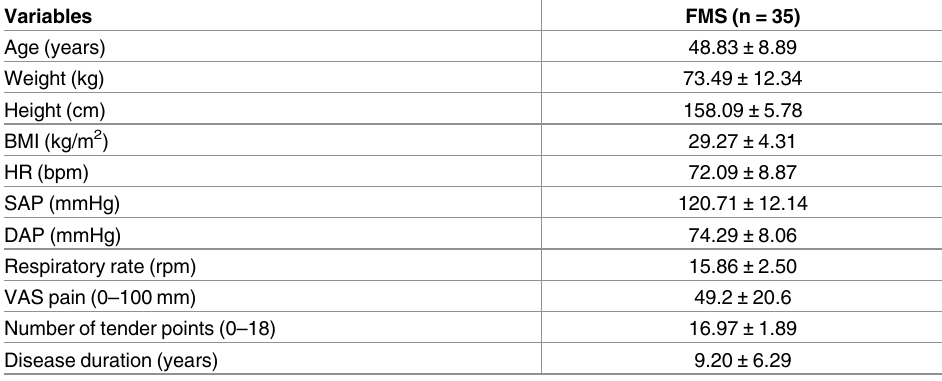
Table 1. Demographic characteristics of the FMS population in resting condition.